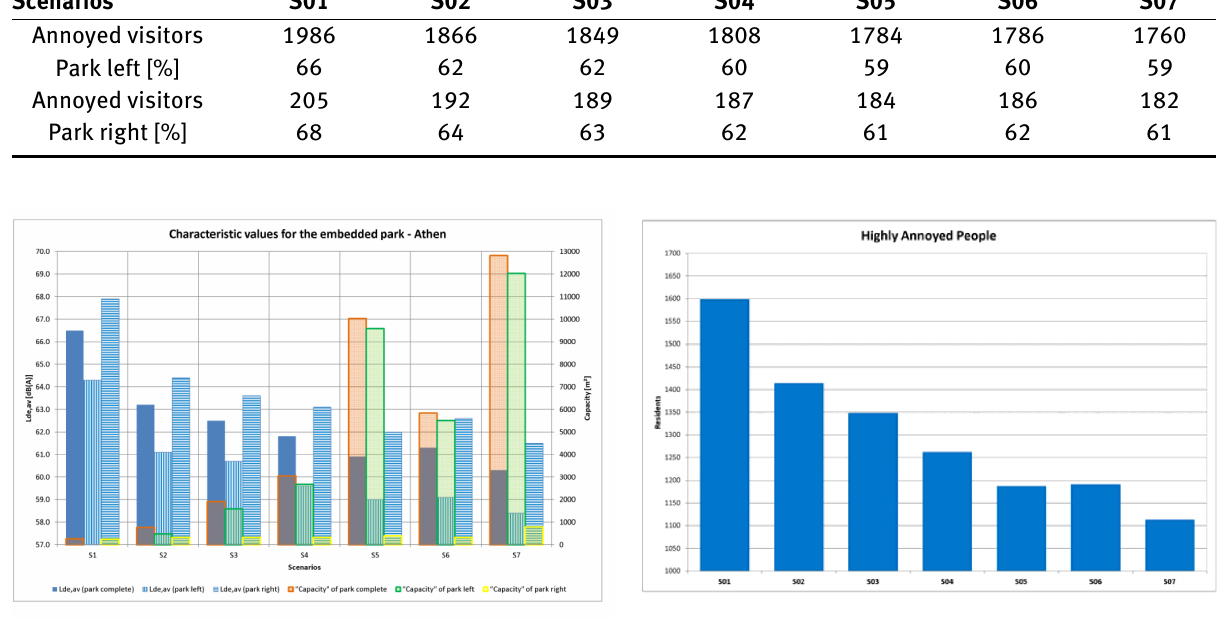
Figure 23: Comparison of the average (arithmetic) noise level L de , av and the capacity of the right-, left- and the entire park area in Athens in various scenario configurations.